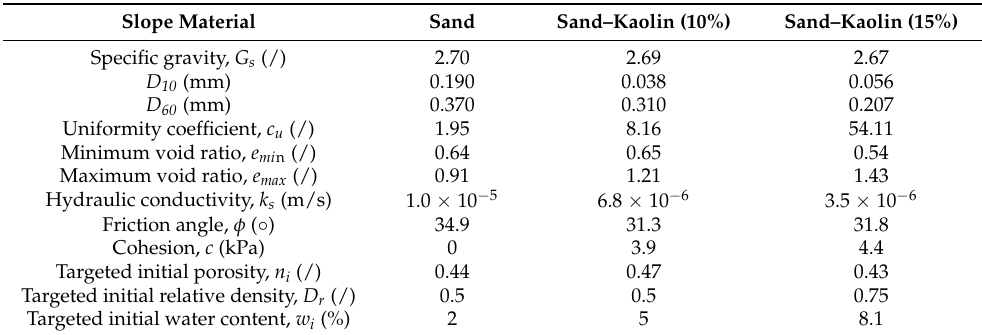
Table 1. Main characteristics of the slope material that was used for simulations. Adopted from Vivoda Prodan et al.